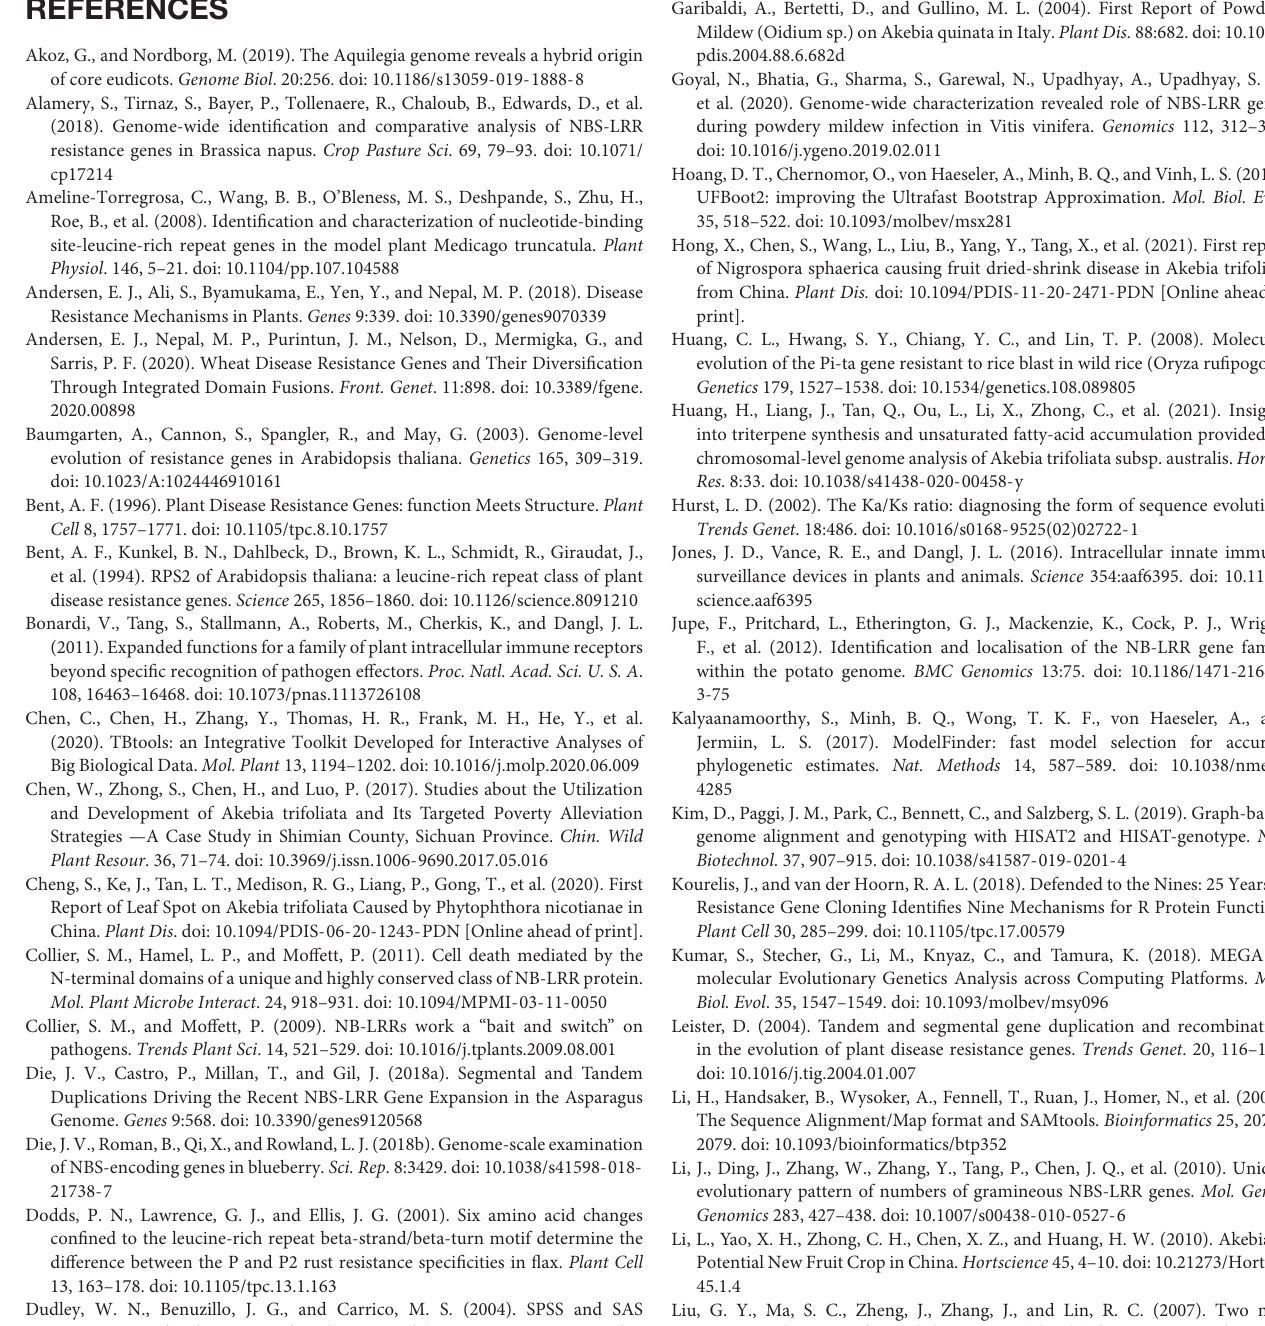
Supplementary Figure 1 | The complete tree of CNL subclass of A. trifoliata NBS proteins. Supplementary Table 1 | Detailed features of identified NBS genes in A. trifoliata . Supplementary Table 2 | Differential arrangement of conserved motifs in NBS domain. Supplementary Table 3 | Discovered Motifs Statistics of NBS domain in A. trifoliata NBS genes.